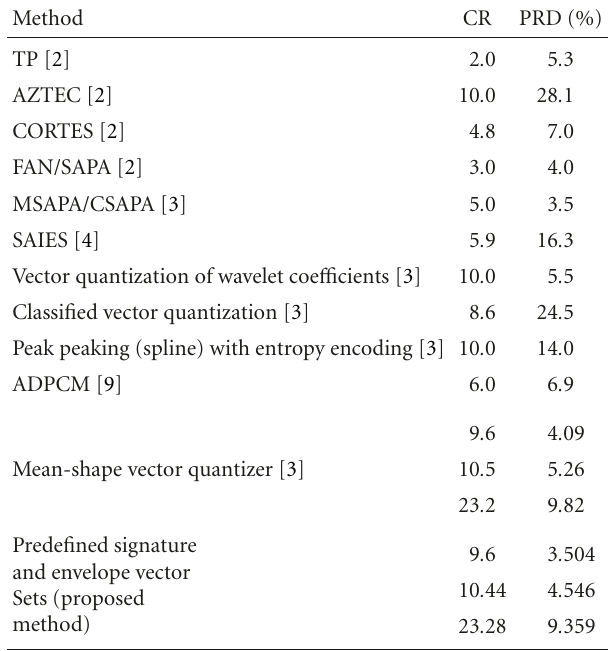
Table 3: Comparison of the proposed method with various ECG compression